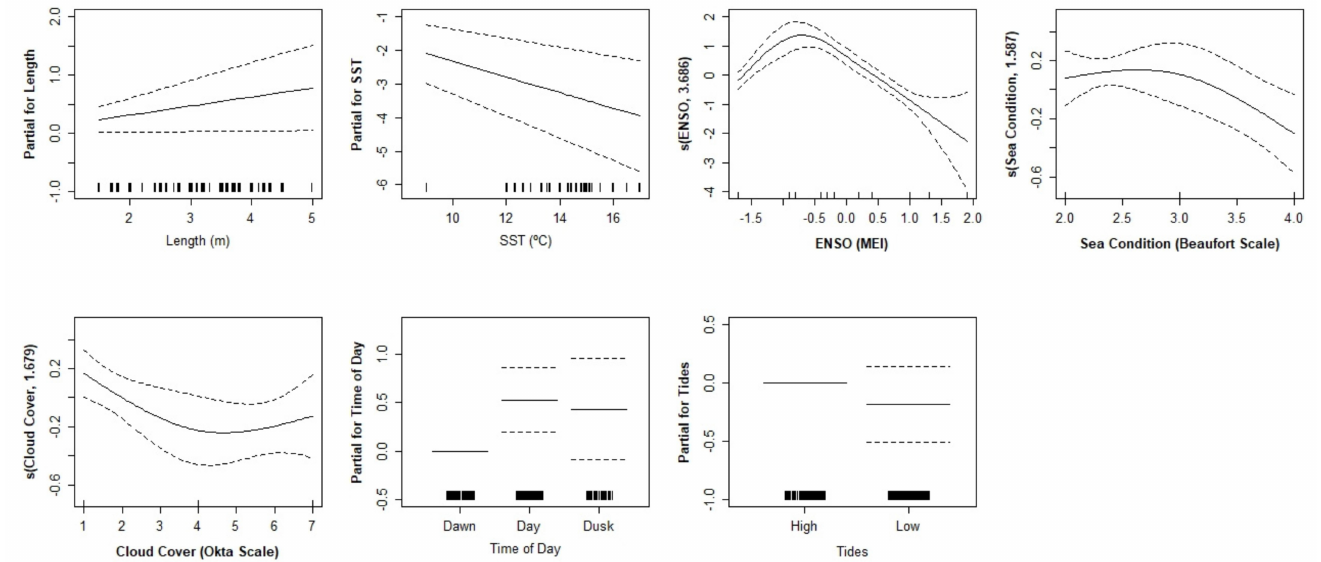
Figure 2. Generalised additive model functions of female white shark behaviour complexity in relation to the explanatory variables. Tick marks above the x-axis indicate the number of observations. The dashed lines represent the 95% confidence intervals of the spline functions. SST = sea surface temperature; ENSO = El Niño Southern Oscillation.